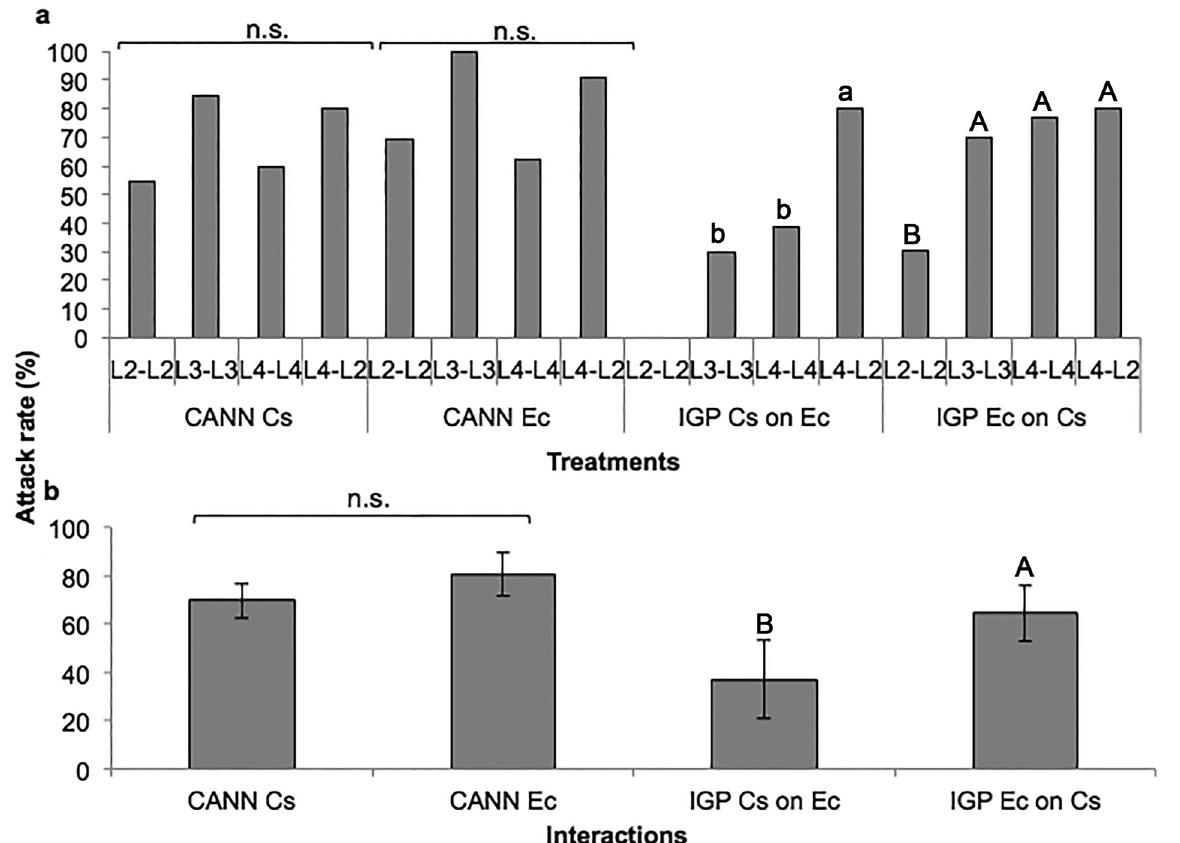
Figure 2. Occurrences of attack between different combinations of larval instars (Panel a ) and mean rates of attack (Panel b ) by larvae of Cycloneda sanguinea (Cs) and Eriopis connexa (Ec) on conspecific or heterospecific larvaeduring 90 min of interaction, in the absence of extraguild prey. CANN, cannibalism; IGP, intraguild predation; L2, second-instar larvae; L3, third-instar larvae; L4, fourth-instar larvae. Different letters indicate significant differences (lower case, among larval combinations of IGP Cs on Ec; upper case, among larval combinations of IGP Ec on Cs). The brackets denote ± standard error. Different letters indicate significant differences ( P